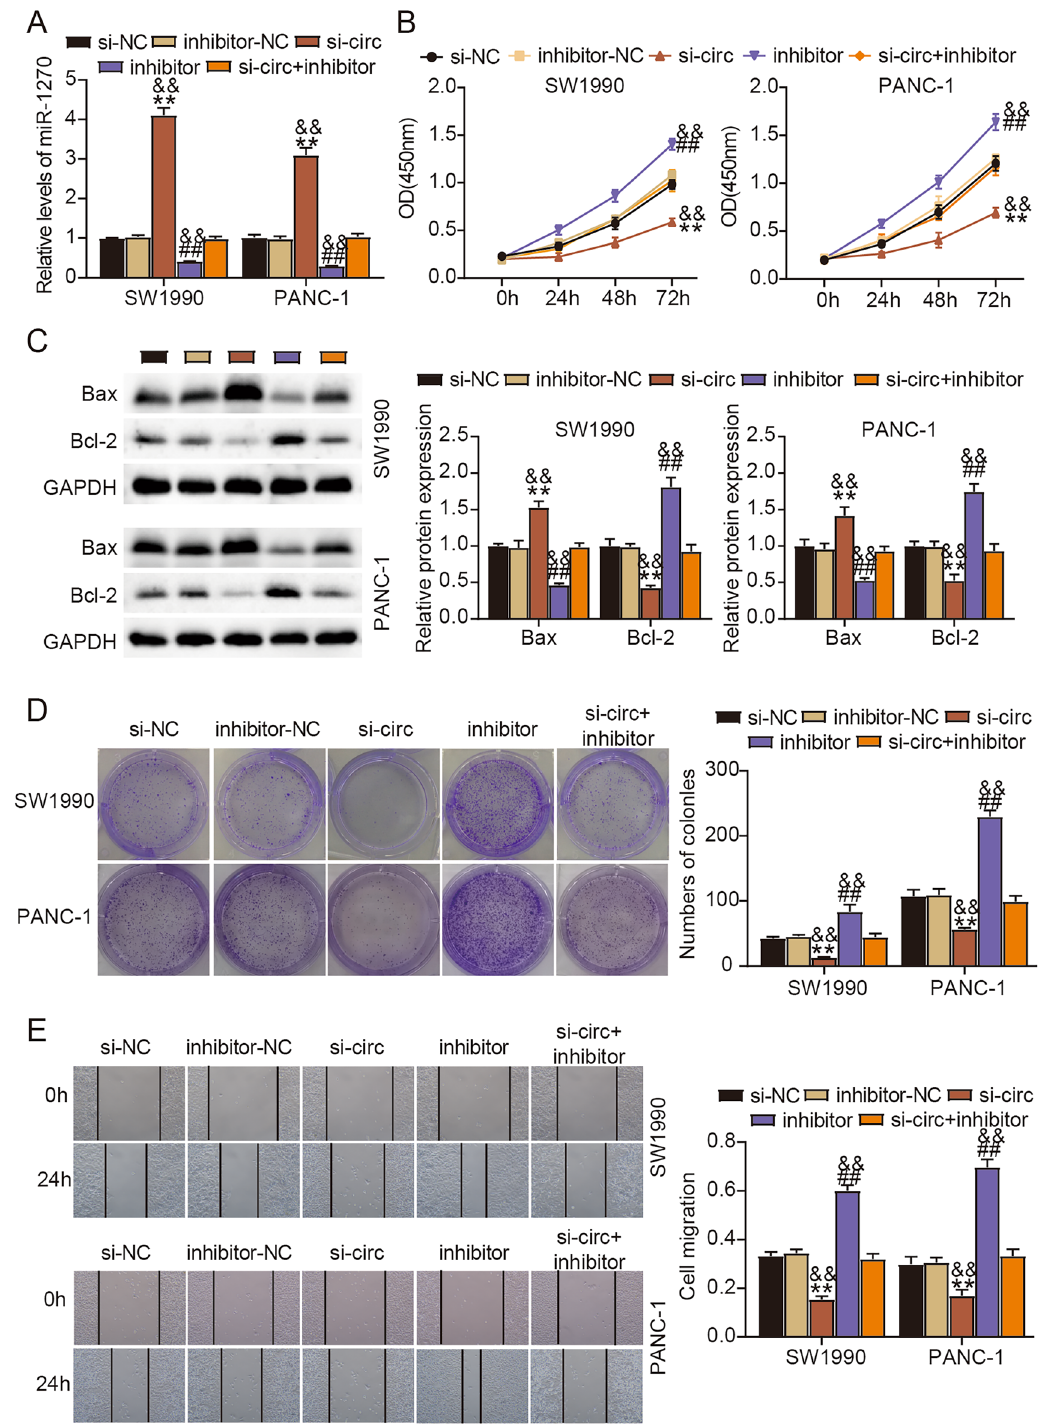
Figure 5. MiR-1270 inhibition reversed the cancer-suppressive effects of silencing circ_0128846 in PC cells. ( A – E ) Rescue experiments were conducted in SW1990 and PANC-1 cells with si-NC, inhibitor-NC, si-circ-1, inhibitor or si-circ-1 + inhibitor transfection. ( A ) MiR-1270 expression in these cells was checked by RT-qPCR. ( B ) Cell proliferation was evaluated by CCK-8 assay. ( C ) Expression of Bax and Bcl-2 was measured by western blotting to assess cell apoptosis. ( D ) Cell clone formation ability was evaluated by colony formation assay. ( E ) Cell migration was evaluated by wound healing assay. ** P < 0.001 relative to si-NC; ## P < 0.001 relative to inhibitor-NC; && P < 0.001 relative to si-circ-1 +